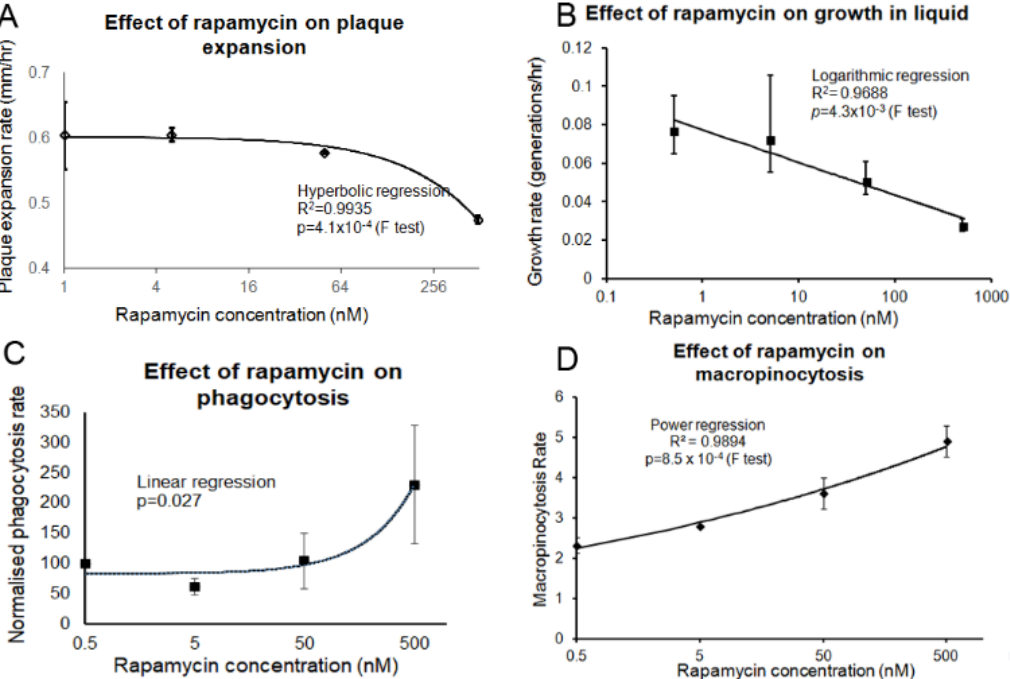
Figure 7. Prolonged rapamycin treatment inhibits growth and promotes endocytosis. ( A ) A scraping of AX2 amoebae grown on an E. aerogenes lawn was transferred to NA plates containing rapamycin concentrations ranging from 5 to 500 nM and an overnight lawn of E. coli B2. The diameter of each Dictyostelium plaque was then measured twice daily for five days and the rate of plaque expansion calculated. The plaque expansion rate was reduced with increasing concentrations of rapamycin. ( B ) AX2 cells were suspended to a final concentration of 1 × 10 4 cells · mL − 1 with rapamycin (0.5 nM, 5 nM, 50 nM and 500 nM) and grown on a shaker at 21 ◦ C. A small amount of medium containing Dictyostelium cells was removed and counted twice daily. The generation time for each strain was then calculated. The generation time increased with rapamycin concentration. ( C ) Cells in HL-5 medium containing rapamycin (0.5–500 nM) were mixed with fluorescently labelled bacterium (DsRed-expressing E. coli ) and the rate of uptake was measured and results were normalised to wild type. The rate of phagocytosis was increased with increasing rapamycin concentrations. ( D ) Cells in HL-5 medium containing rapamycin (0.5–500 nM) were allowed to take up HL-5 medium containing the fluorescent marker FITC-dextran. Aliquots were removed at specific time points, washed and lysed to release cell contents. Fluorescence was then measured using a fluorometer. Increasing rapamycin concentrations correlated with increased macropinocytosis rates. The regression for all the graphs was significant at the indicated p values. The lines were fitted with the least squares method.